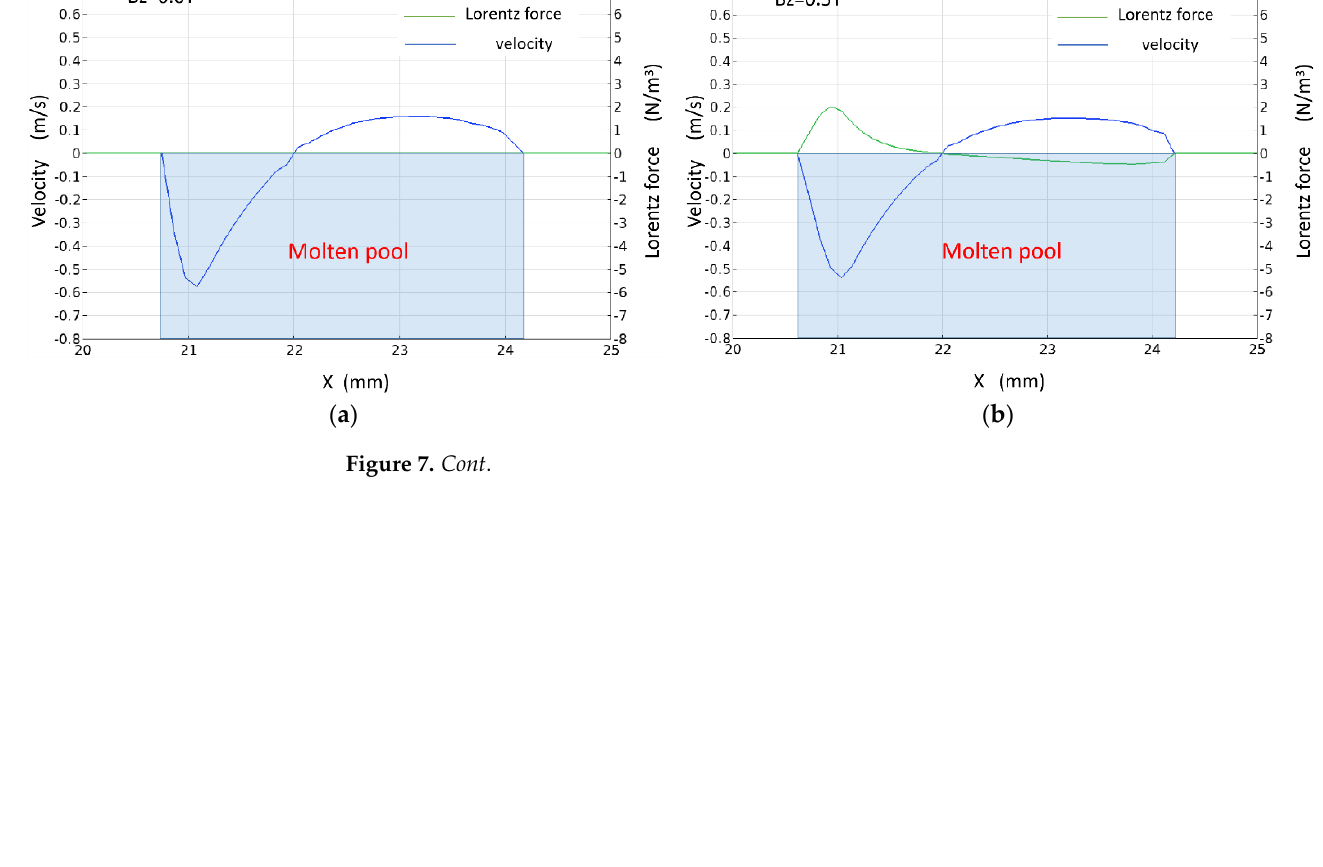
( e ) Figure 7. Magnitude of Lorentz force at different magnetic field strengths (t = 4.5 s). ( a ) Bz = 0.0 T; ( b ) Bz = 0.5 T; ( c ) Bz = 1.0 T; ( d ) Bz = 1.5 T; and ( e ) Bz = 2.0 T. 4.2.2. Influence of Marangoni Force on the Flow Field of Laser Melting Pool The effect of the Marangoni force on the flow field for different magnetic fields is shown in Figure 8a–e. It can be seen that the Marangoni force on the flow field of the laser melting at the different magnetic fields is consistent, i.e., the flow velocity of the pool is higher than that without the Marangoni force when the Marangoni force is considered. This is because the direction of the Marangoni force is along the tangential direction of the